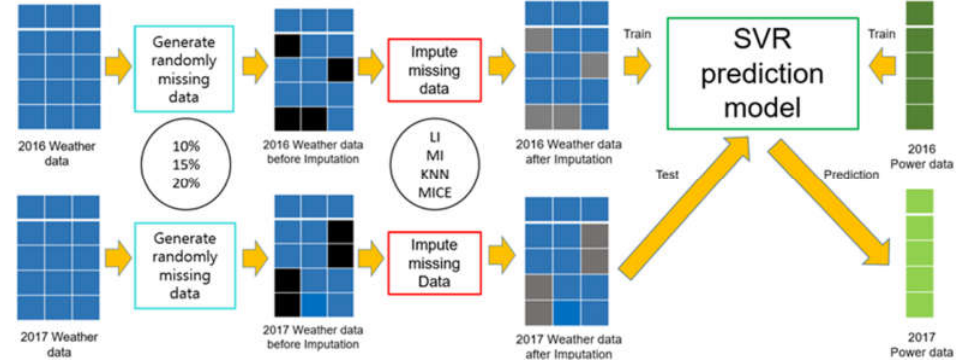
Figure 2. Time step of data and time horizon of the forecasting model.